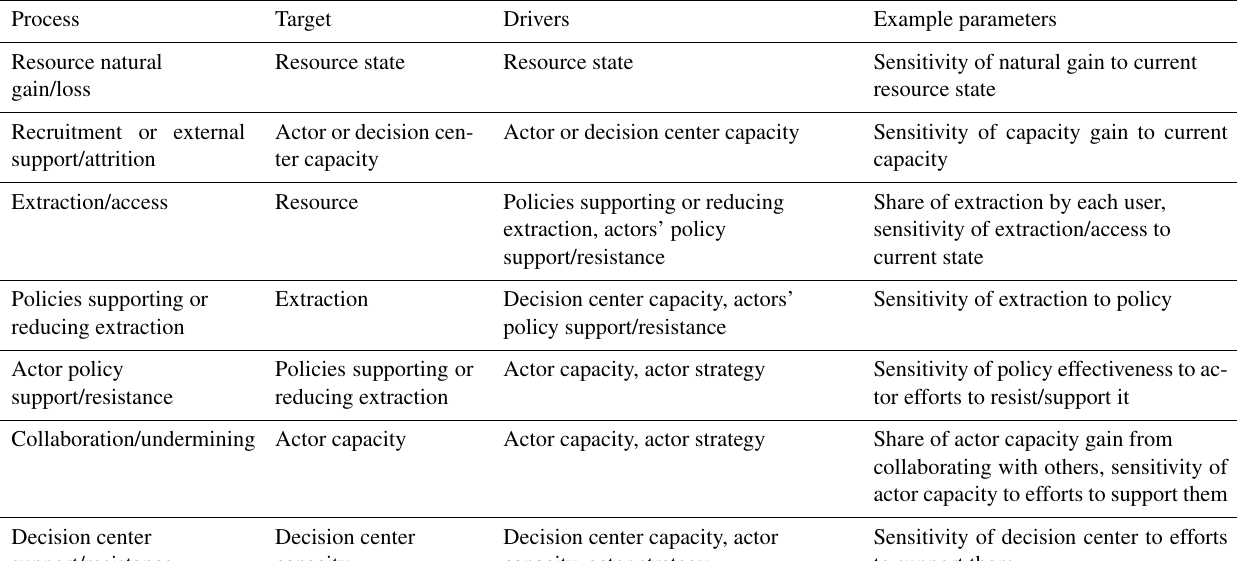
Table 1. Summary of modeled processes, the variables or sub-processes linked through these processes, and example scale or exponent parameters associated with the processes. The scale parameters represent the significance of certain processes in driving changes to the state variables, while the exponent parameters represent the sensitivity of the processes to the drivers. The last three processes are driven in part by actors’ strategies, which are represented though how they allocate their capacity to maximize their resource